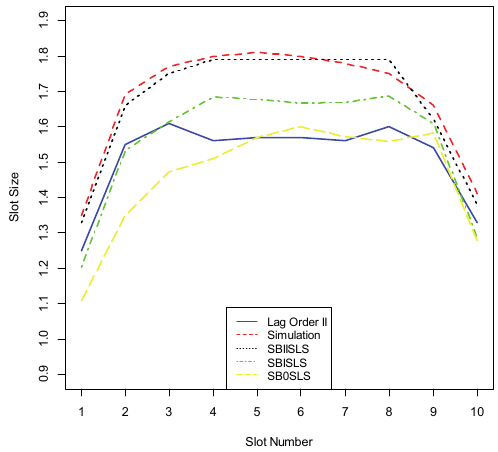
Fig. 2. Optimal lot size for SBKSLS compared with lag order method and simulation with quadratic